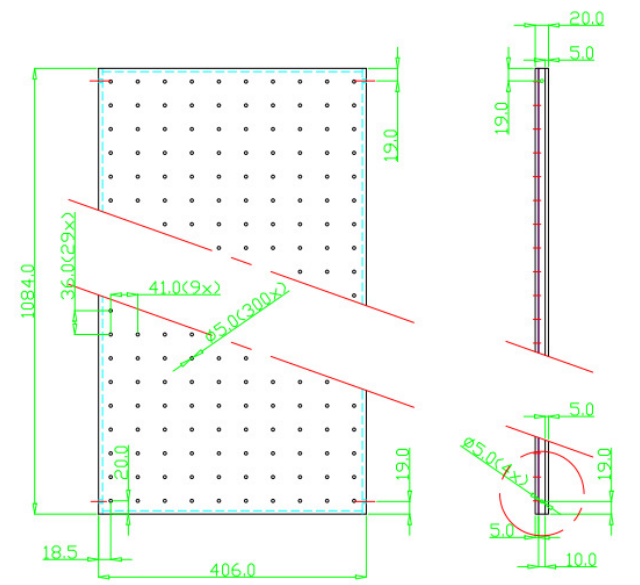
Figure 2. Geometry of the perforated thin box, only 15 rows of the holes are shown for brevity (all units are in mm). ( a ) Front view ( b ) side view.